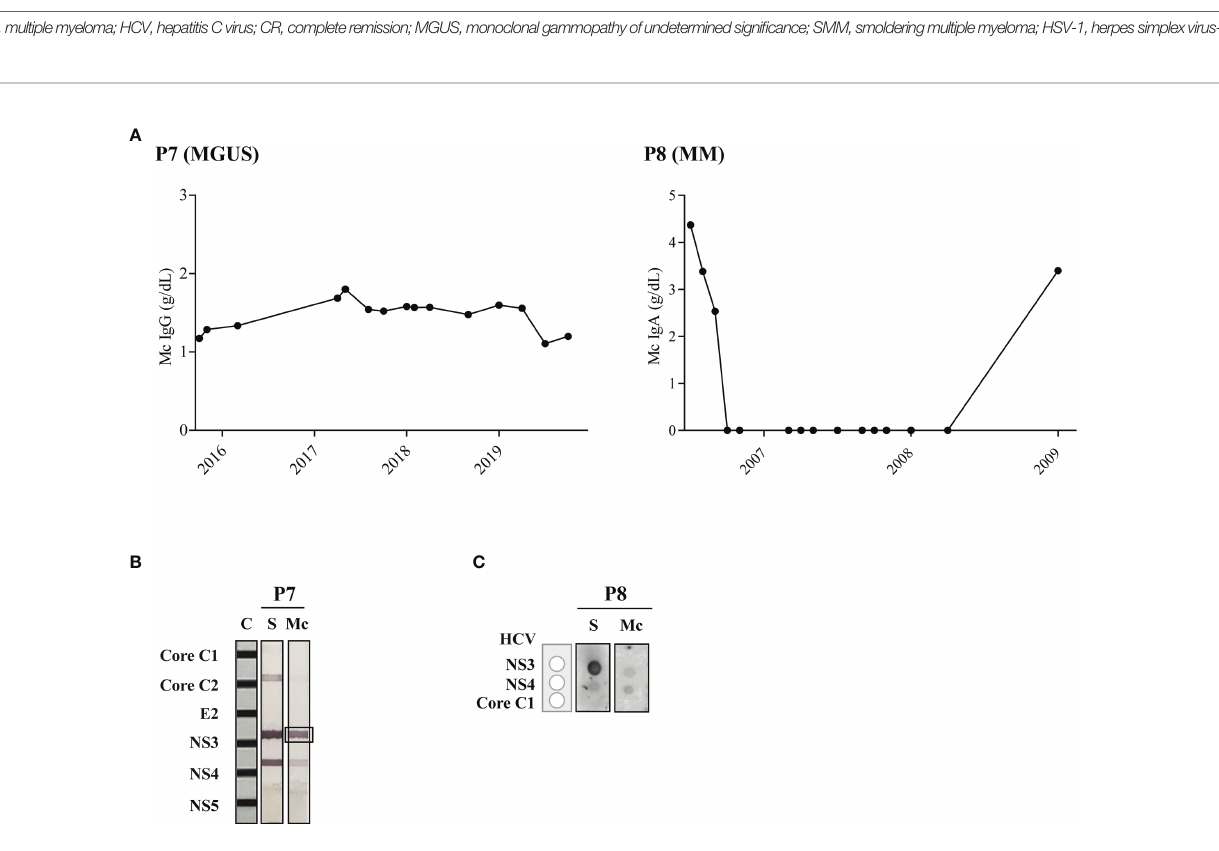
FIGURE 3 | Disease evolution and evaluation of HCV recognition by the monoclonal Ig from patients who were not treated with antiviral drugs. Panel (A) shows the quantity of monoclonal IgG as determined by serum protein electrophoresis. Panel (B) shows the INNO-LIA ™ HCV test used to detect reactivity of the serum IgGs and of the puri fi ed monoclonal IgG for Patient P7, which strongly recognized the HCV NS3 protein. Panel (C) shows the dot-blot assay used to detect reactivity of serum IgAs and of the puri fi ed monoclonal IgA in patient P8, which reacted against HCV NS3 protein. A weaker signal was noted for HCV NS4, possibly due to contaminating polyclonal IgAs. C, positive controls; S, serum; Mc, monoclonal Ig.